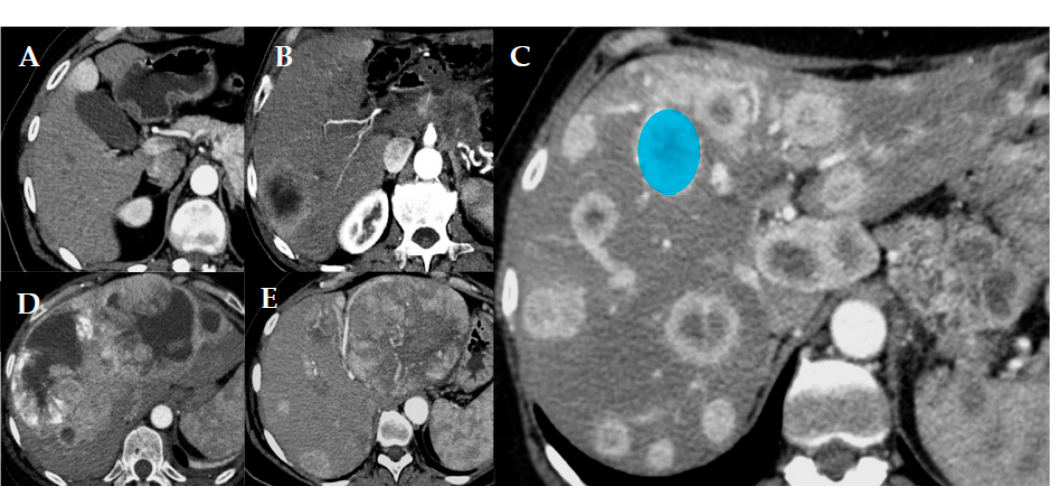
Figure 1. Different patterns of pancreatic neuroendocrine tumor (p-NET) metastatic spread in the liver. Uninodular ( A ), paucinodular ( B ), multinodular ( C ), confluent multinodular ( D ), and bulky ( E ). In image (C) an example of how the volume of interest (VOI; blue circle) was placed when performing the texture analysis is reported.